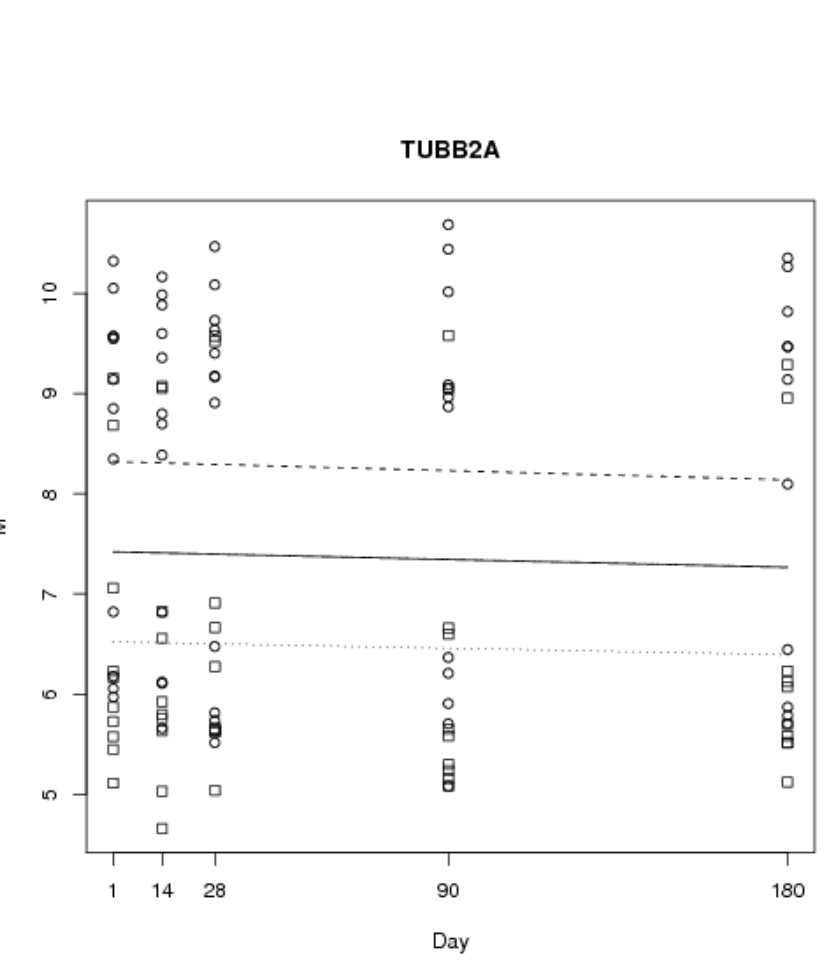
Figure 3 – Plot of TUBB2A’s fitted longitudinal profiles. We have identified TUBB2A as a gene with a potentially novel gender effect. Observations on females are shown as squares, and those on males are shown as circles. The solid line is the overall mean expression level over time, after removing age and gender effects. The dotted line is the mean plus gender effect for females, and the dashed line is the mean plus gender effect for